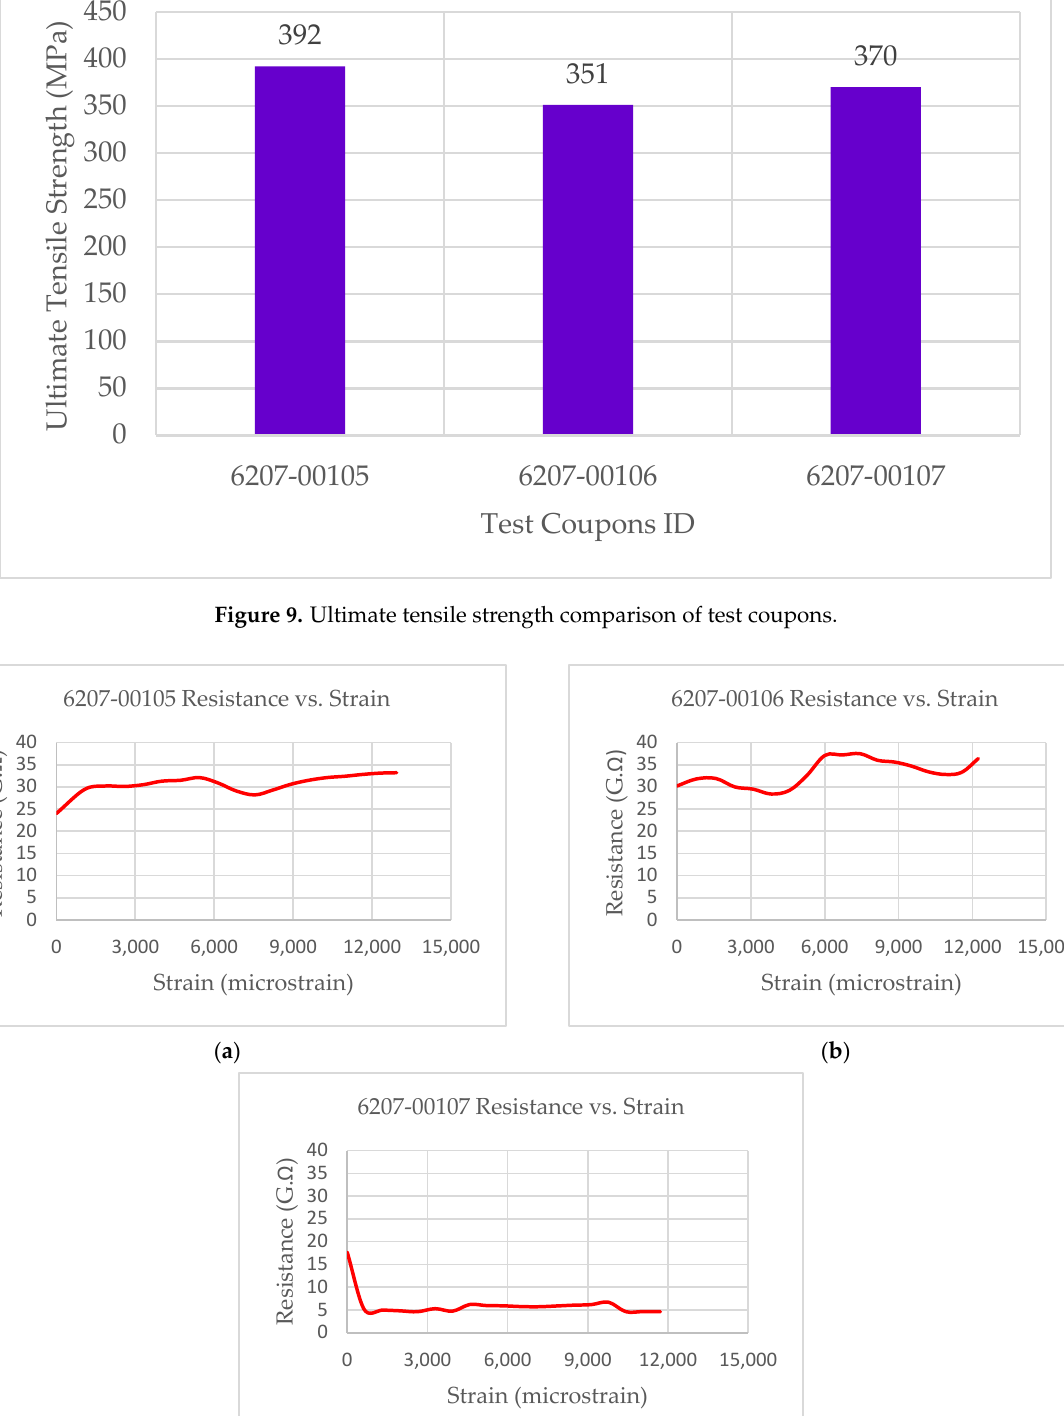
Figure 8. Strain-strain characteristics of multifunctional test specimens: ( a ) 6207-00105; ( b ) 6207-00106; ( c ) 6207-00107.